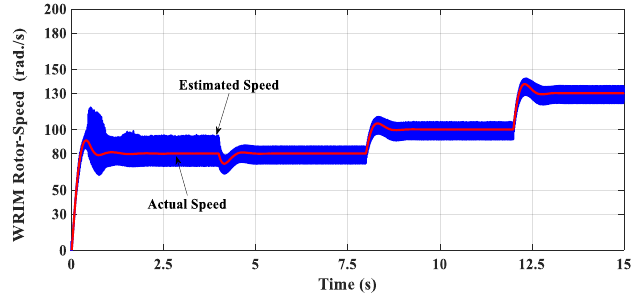
Figure 6. Estimated and actual speed response of IM.